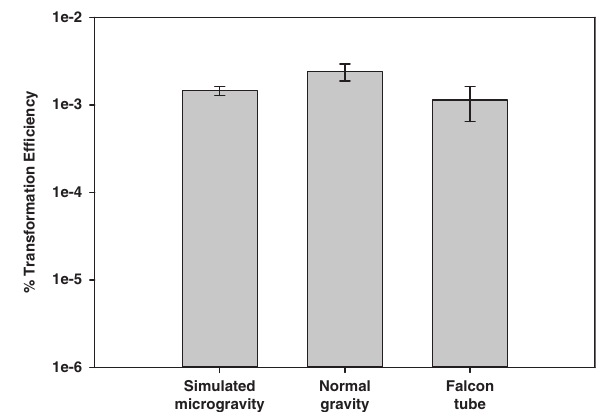
Fig. 6 S. mutans competence phenotype assessed in simulated microgravity and normal gravity HARV cultures. Simulated micro- gravity and normal gravity HARV cultures, as well as a parallel static Falcon tube control culture, were each grown for 1.5 h in bio fi lm media prior to addition of 2 µg pOri23 plasmid DNA. All three cultures were then grown for 2.5 more hours followed by harvest and serial dilution plating on BHI agar ± 10 µg/ml erythromycin (selective antibiotic to monitor plasmid transformation). Transforma- tion ef fi ciency was calculated as the percentage of transformants (CFU/ml on BHI + erythromycin) among total viable cells (CFU/ml on BHI). Data represent the average of n = 3 independent experiments. Error bars =